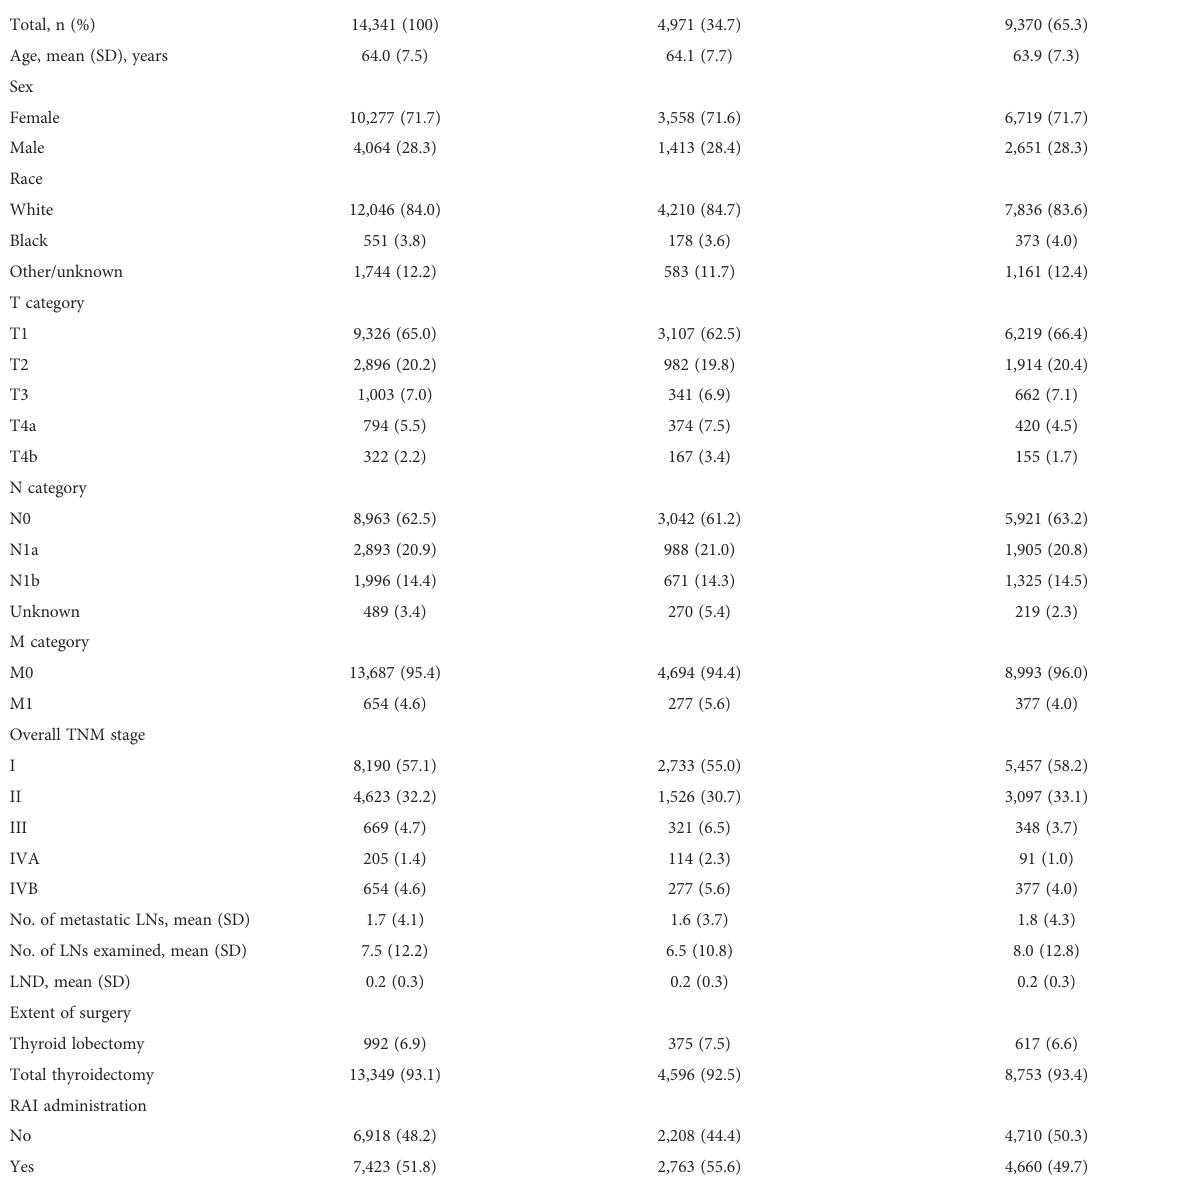
TABLE 1 Patient and tumor